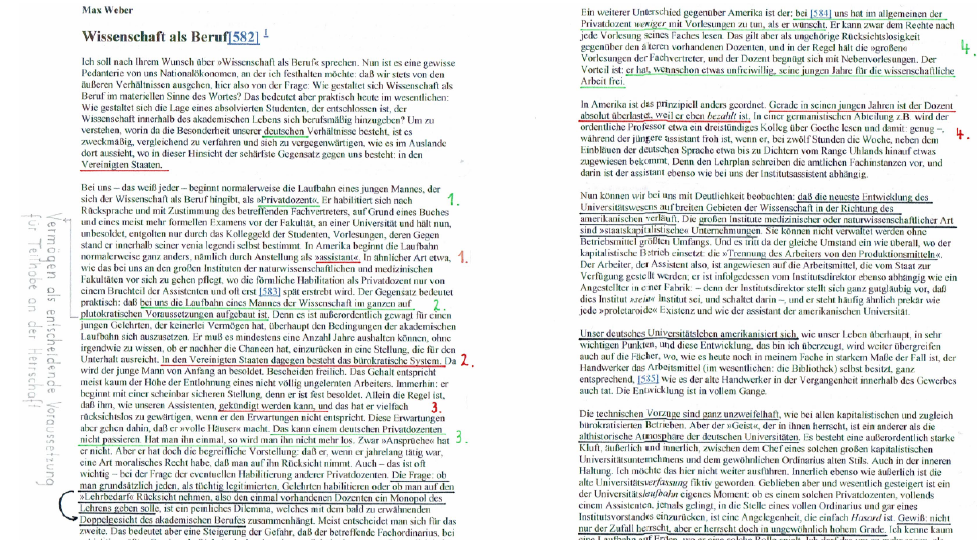
Figure 1. Annotating Max Weber for structure (Reprinted from Weber 1930, pp. 5–7).